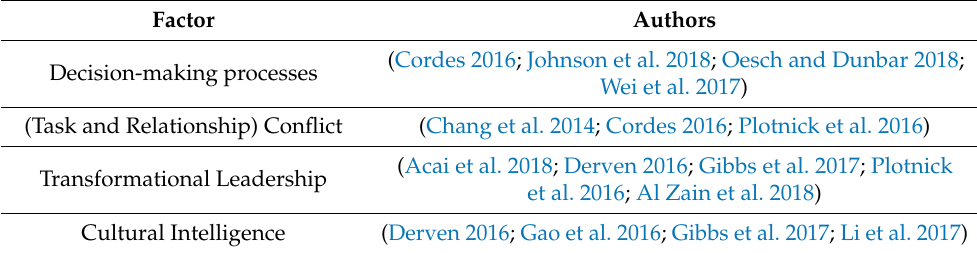
Table 1. Factors affecting the decision-making process of virtual teams. Factor Authors (Cordes 2016; Johnson et al. 2018; Oesch and Dunbar 2018; Decision-making processes Wei et al. 2017) (Task and Relationship) Conflict (Chang et al. 2014; Cordes 2016; Plotnick et al. 2016) (Acai et al. 2018; Derven 2016; Gibbs et al. 2017; Plotnick Transformational Leadership et al. 2016; Al Zain et al. 2018) Cultural Intelligence (Derven 2016; Gao et al. 2016; Gibbs et al. 2017; Li et al.